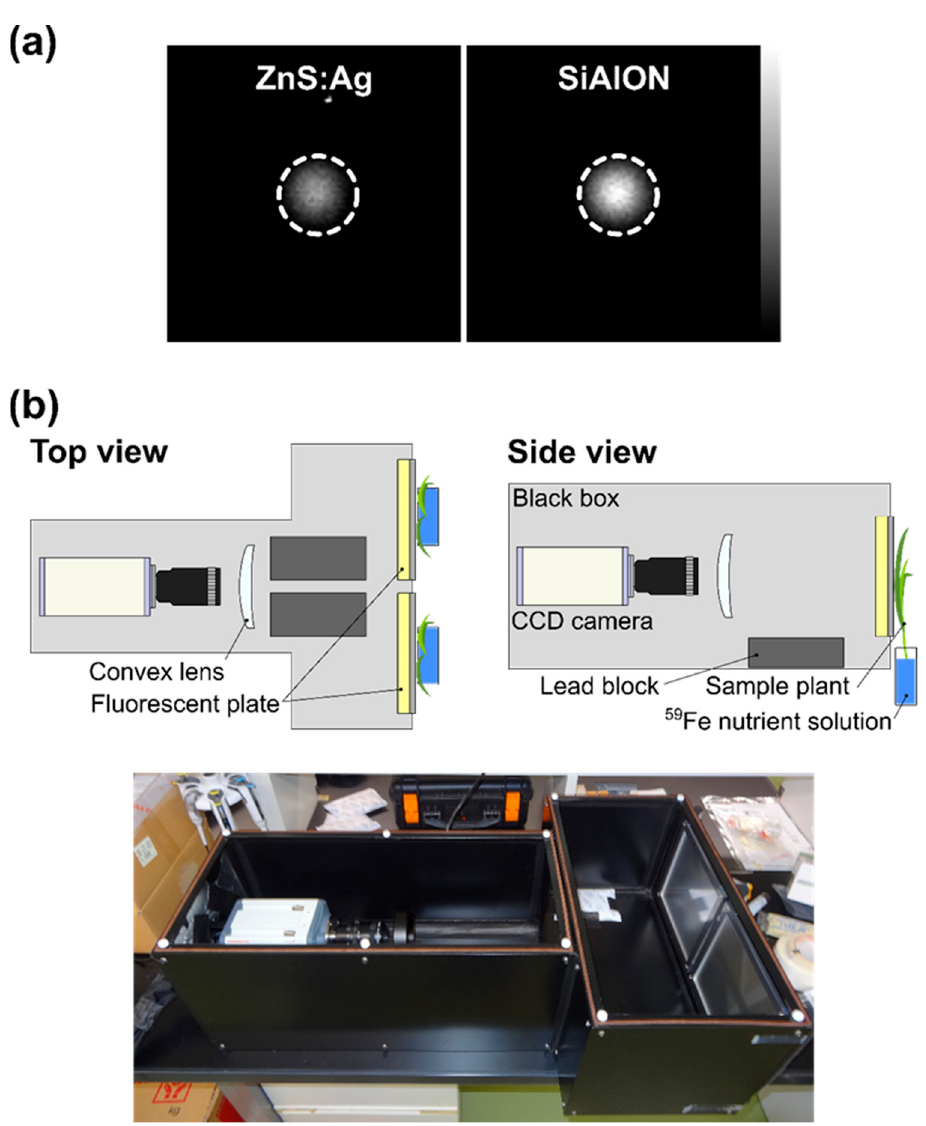
Figure 1. Improvement in “live-autoradiography”. ( a ) Images of a 137 Cs point source with a diameter of 4 mm and radioactivity of 100 kBq acquired over 5 min using ZnS:Ag (left) and SiAlON (right) scintillators. The dashed circles in the figure indicate ROIs. ( b ) Schematic of improved live-autoradiography system (top view on the left, side view on the right) and photo of live-autoradiography system.